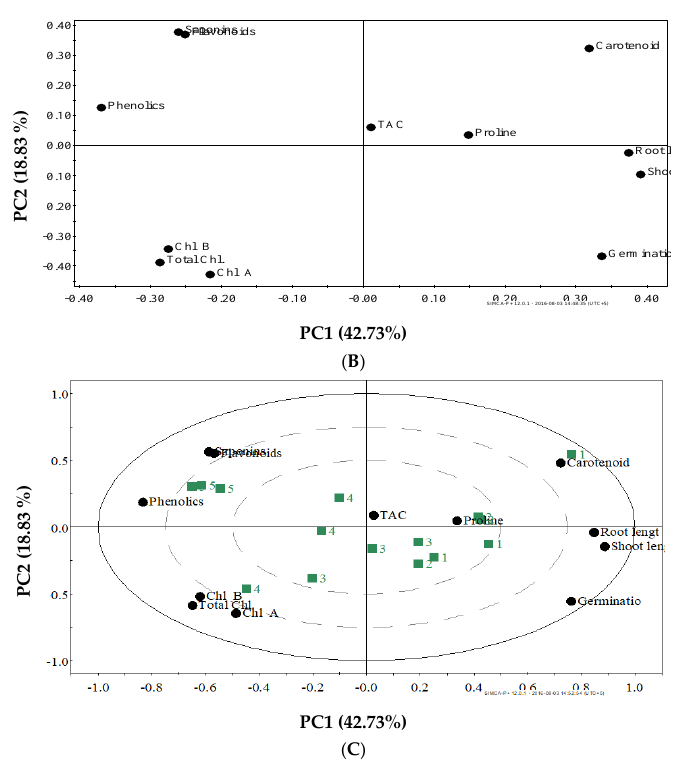
Figure 11. Principal component analysis (PCA) of tomato data under salinity stress. Score scatter plot of PC1 vs. PC2 ( A ), score loading plot of PC1 vs. PC2 ( B ) and score biplot( C ). 1 = control, 2 = 25 mM, 3 = 50 mM, 4 = 100 mM and 5 = 200 mM of NaCl.